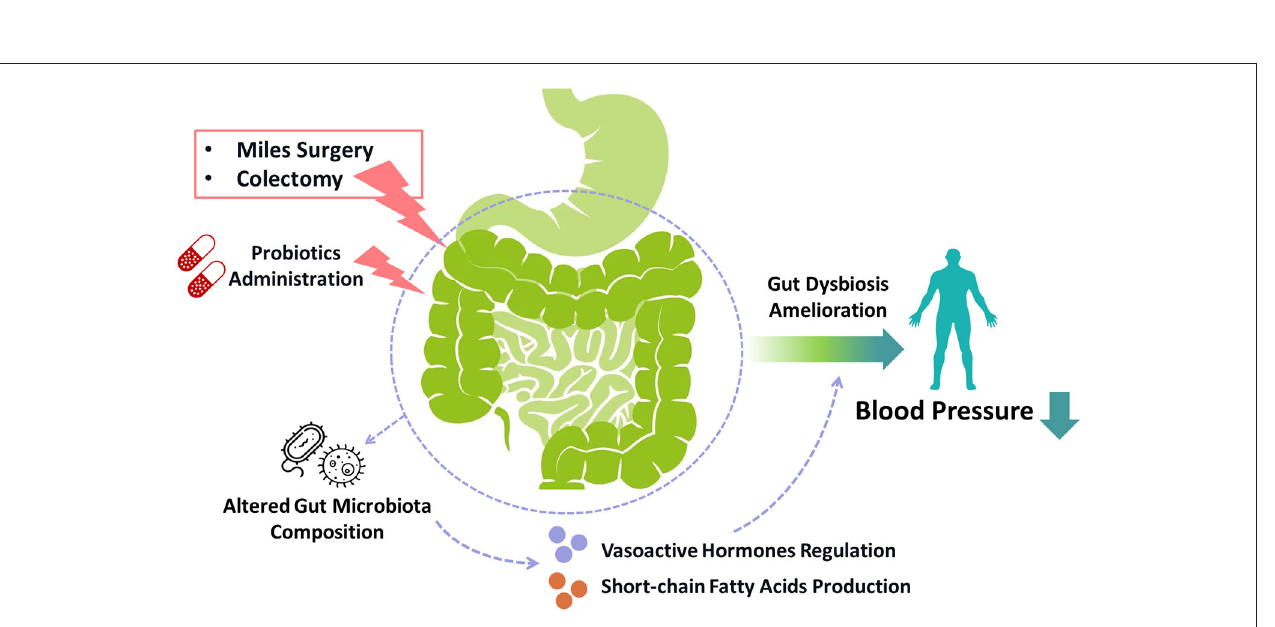
Frontiers in Cardiovascular Medicine | www.frontiersin.org